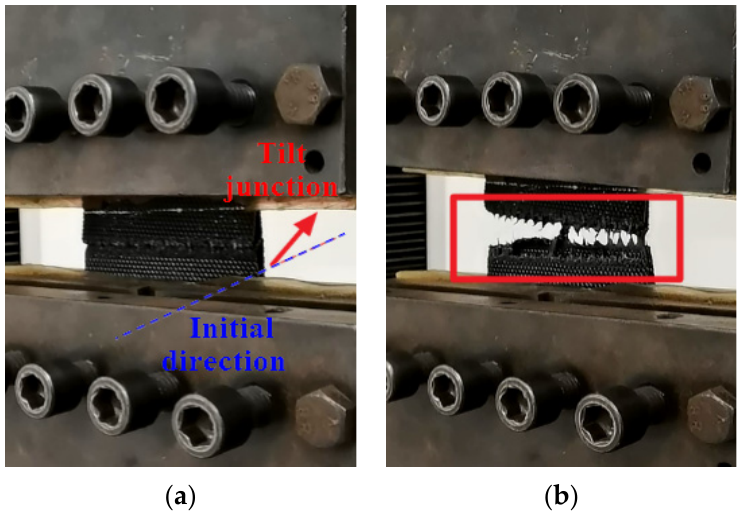
Figure 18. Different failure modes of the junction: ( a ) Directional change of the junction, ( b ) failure at the connection of the junction and the strip.